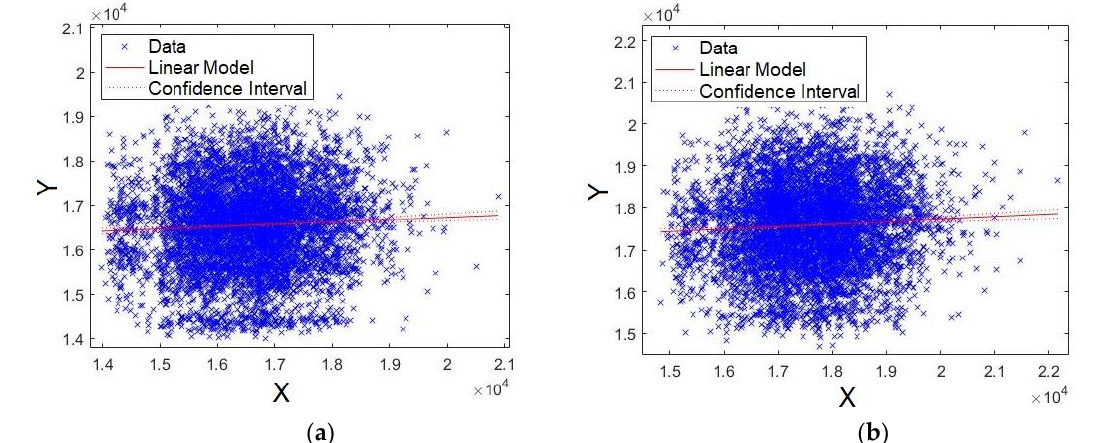
Figure 13. XY straight-line for: (a) formant F15 and (b) formant F16 .